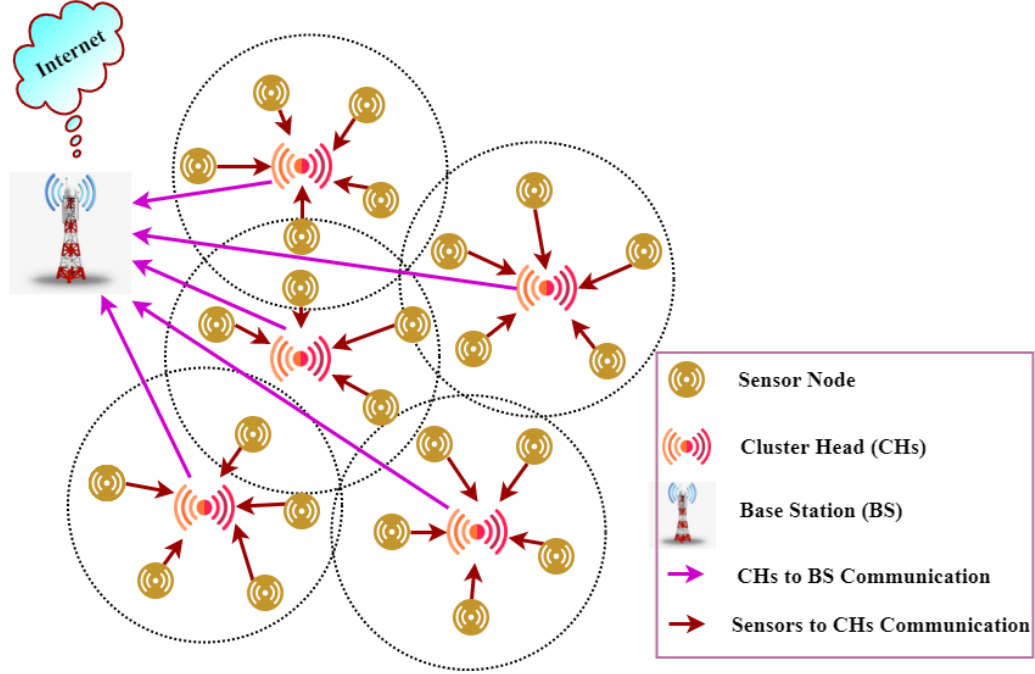
Figure 1. Generic Clustering Architecture in WSN.